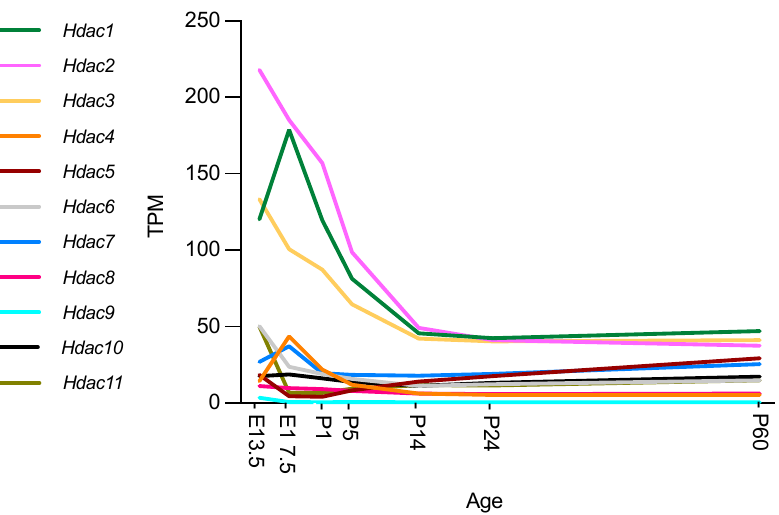
Figure 2. Hdac expression during mouse nerve development. Expression in transcripts per million (TPM). Graphs ggenerated based on RNA-seq data from Gerber et al., 2021, GEO database accession number GSE137870 [56]. Authors used four independent samples for bulk RNA sequencing at every time point, two from male and two from female mice. At E13.5 and E17.5, sciatic nerves were pooled from two embryos of the same sex per sample. At all postnatal time points examined (P1, P5, P14, P24, and P60), sciatic nerves from one mouse were used for each independent sample [56]. All HDAC subtypes are expressed in nerves. Class I Hdacs , which include Hdac1 , Hdac2 and Hdac3 , are mostly expressed during development and at P60. Hdac6 and Hdac11 are predominantly expressed during embryonic development (E13.5) after which expres- sion decreases significantly. Similarly, Hdac4 is mainly expressed during embryonic de- velopment, although expression is significantly upregulated between E13.5 and E17.5 and then again significantly downregulated by P1. Gerber et al. further describe in their single cell sequencing data (see Figure 3) that SCs are not the main cell source for Hdac4 , Hdac6, Hdac7 , and Hdac11 gene expression levels during development, with fibroblast-related cells and endothelial cells contributing. Expression levels of these Hdacs are, overall, not as high as Hdac1 , Hdac2 and Hdac3 , which are highly expressed during embryonic devel- opment and then reach significantly lower levels by P14, that are maintained into adult- hood. Hdac5 gene expression is significantly upregulated during early embryonic devel- opment (E13.5), and then drops before birth (E17.5). After birth, Hdac5 and Hdac7 are both gradually, but significantly, upregulated until P60. SCs are, however, also not the main cell source contributing to the expression of these HDAC subtypes, with especially peri- cytes/endothelial cells contributing (Figure 3) [56].